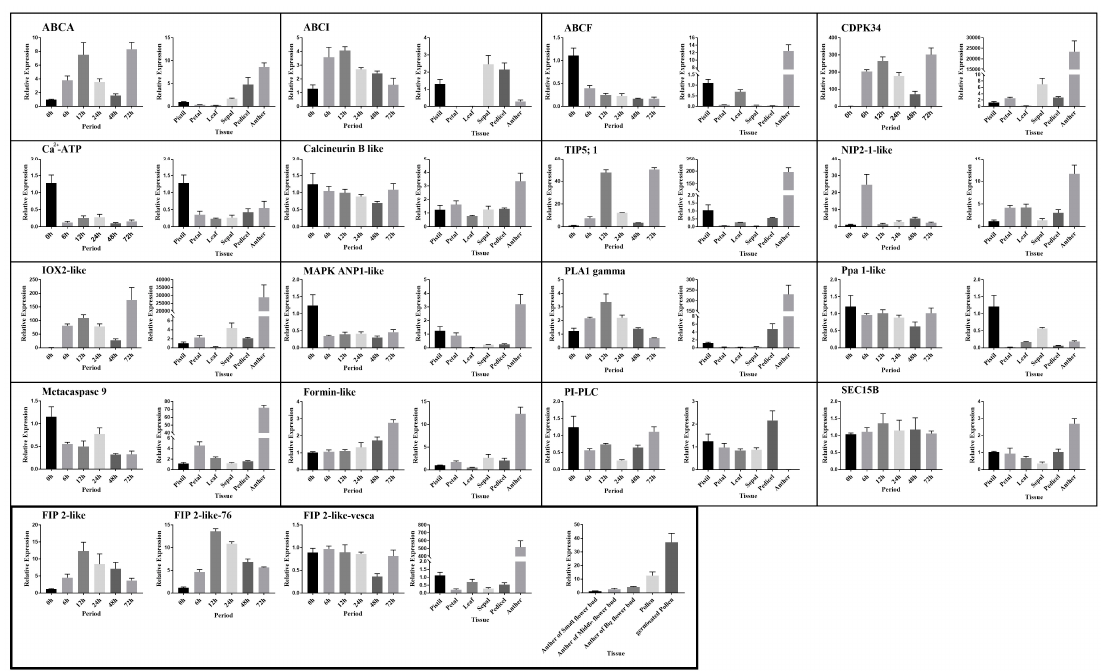
Figure 8. Relative gene expression of selected genes in manually self-pollinated pistil after 0, 6, 12, 24, 48, and 72 h, and tissue-specific (style, leaf, petal, sepal, pedicel, anther) expression pattern analysis. The materials used in FIP2-like-76 and FIP2-like-vesca are, respectively, the pistil of Ls-S 2 -76 and F. vesca 41, and the others are from Ls-S 2 -53. Mean values and standard deviations (SD) were calculated from three replicates, p < 0.05. The IDs and annotation information of these abbreviated genes are displayed in Table S1 and Additional File